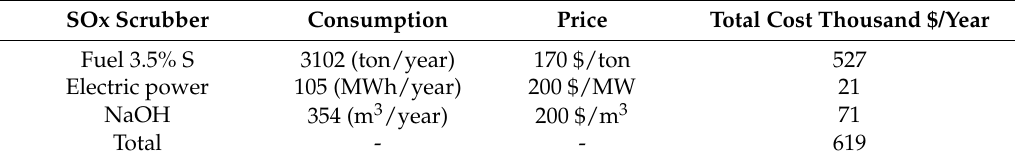
Table 5. Yearly running cost in USD (United States dollar) using high sulfur fuel and scrubber.